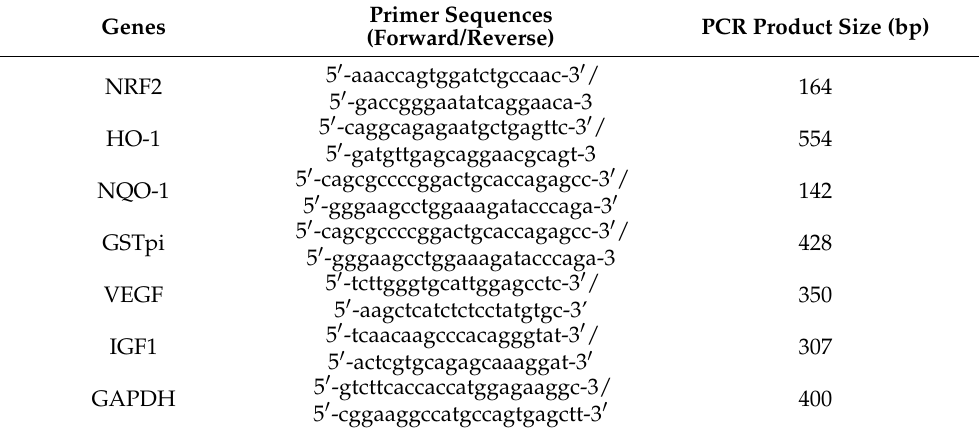
Table 1. Human Primer sequences for reverse transcriptase-polymerase chain reaction (RT-PCR). Primer Sequences Genes